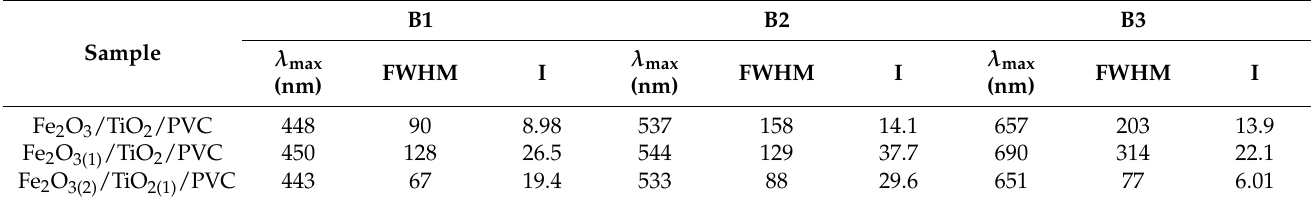
Table 1. Experimental data of absorption bands for samplesFe 2 O 3 /TiO 2 /PVC (FWHM—full width at half maximum, shown in nm).